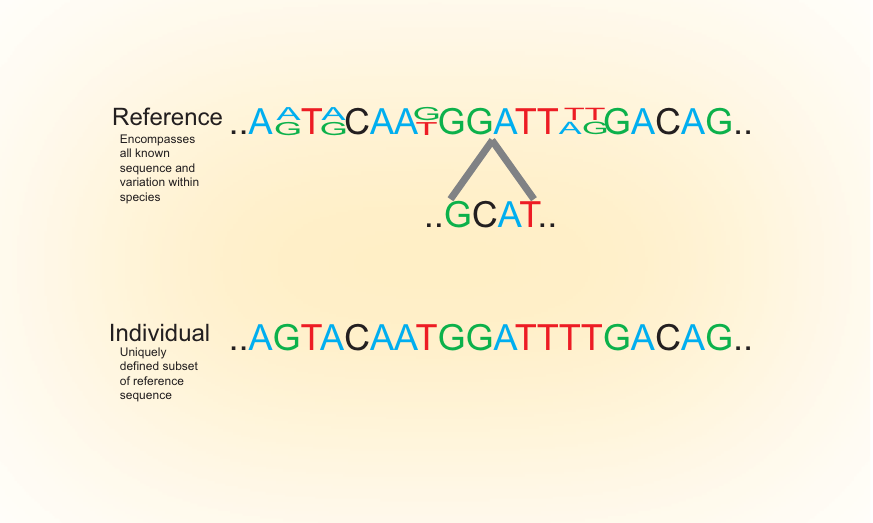
Figure 1. Conceptualizing the Genome. The determination of many thousands of genomes will require a precise definition of what a genome sequence represents. We envisage a hierarchy in which a reference genome comprising all known sequences within a species is placed at the topmost level. A subset of the reference sequence defines a strain or population genome that includes all known polymorphisms within the population. At the individual level is a uniquely defined genome. Such a defined hierarchy would facilitate unique identifiers for classes within each level (for example, for a microbial isolate a Unique Genome Identifier could take the form XXX-YYY-ZZZ, where XXX denotes the species, YYY denotes the strain, and ZZZ denotes the specific isolate sequenced). This hierarchy would also enable efficient data storage of complete genome information for individuals, because the information stored at a lower level of specification needs only to describe what is specific to that level.